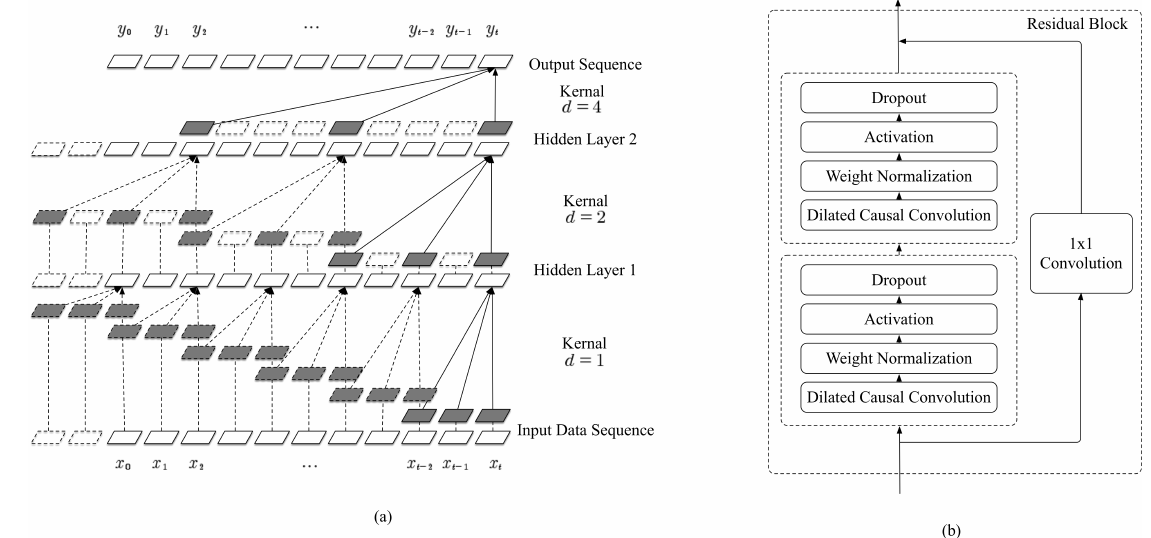
Figure 4. The structure of dilated convolution and residual connections, where each parallelogram is a neuron, solid arrows are used to depict the data flow of the right-most neuron and dashed arrows represent other data flow. ( a ) Dilated convolution; ( b ) Residual